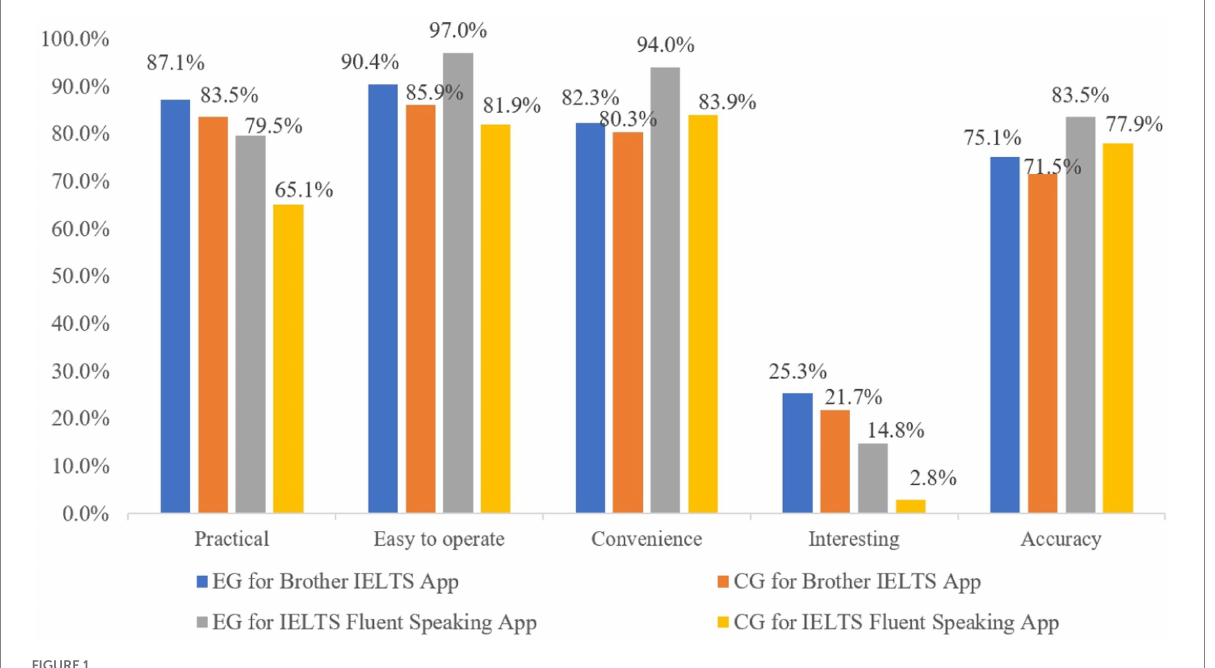
FIGURE 1 The distribution of EG and CG students’ statements about the two